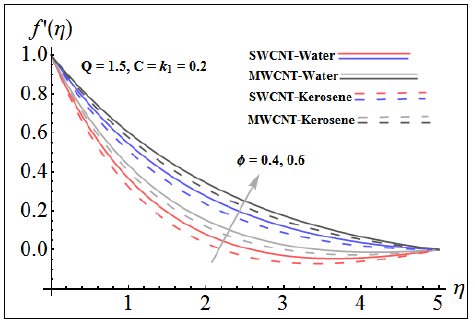
Figure 3. Behavior of f ′ ( η ) for increased values of ϕ .